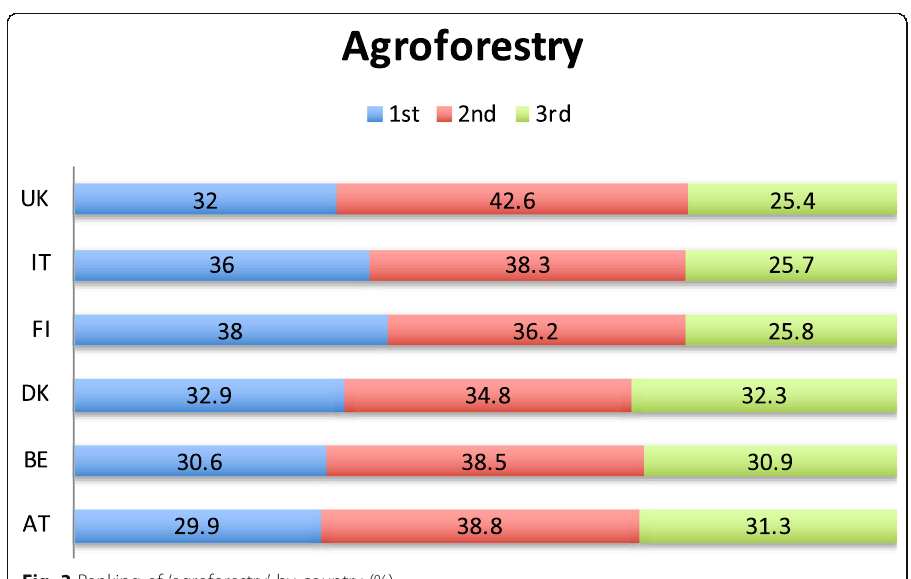
Figs. 6, 7 and 8. All three of the models showed close fits with the observed data, as re- ported in Table 13.